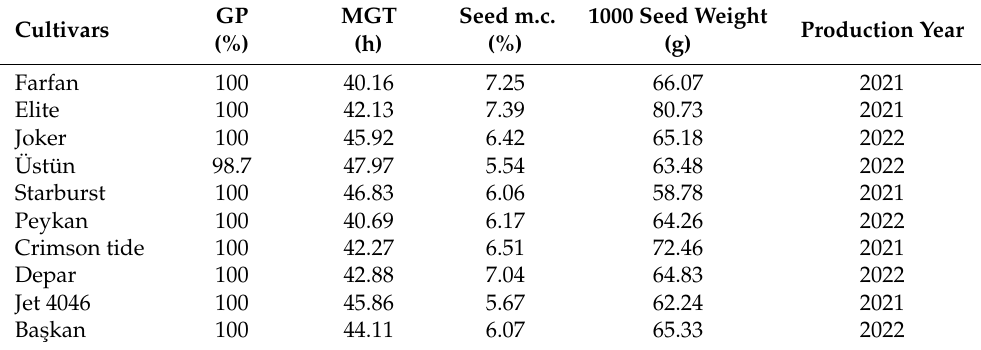
Table 1. Changes in germination percentage of normal germination (GP), mean germination time (MGT, h), seed moisture content (m.c., %), 1000 seed weight (g), and production year of ten hybrid watermelon